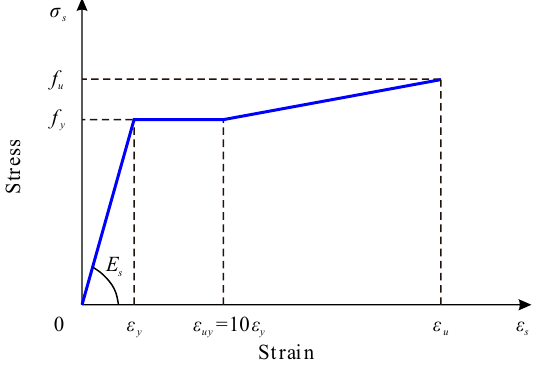
Figure 11. Material constitution of steel.